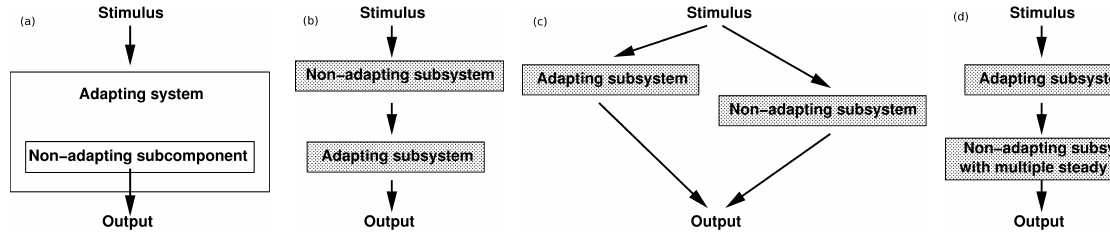
Figure 4. Examples of various adapting and non-adapting systems. ( a ) A signal transduction pathway in which a specified upstream quantity adapts, but the output species further downstream does not, because the output depends on a non-adapting subcomponent of the upstream adapting quantity; ( b ) Similar to that in ( a ), except that here the upstream quantity does not adapt, but the subcomponent adapts, and so the output species adapts as well. We will see later that one may think of the adapting subcomponent as the sum of the states of the receptor containing phosphorylated CheA, and the upstream non-adapting quantity as some other function involving the various phosphorylated and unphosphorylated states; ( c ) An example of a signal transduction pathway in which a specified upstream quantity adapts, but the output species further downstream does not, because the output depends on both the adapting quantity and another non-adapting quantity; ( d ) An example of a signal transduction pathway in which a specified upstream quantity adapts, but the output specified further downstream does not because it depends on an intermediate subsystem which possesses more than one stable steady state. Transient changes in the upstream quantity may cause the intermediate subsystem to reach a steady state different from its prestimulus